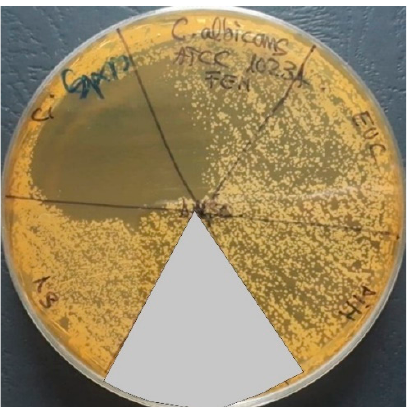
Figure 6. The aspect of the inhibition zones expressed by the yeast strain Candida albicans ATCC 10231 in the presence of tested EO at 1/10 dilution in DMSO; FEN (fennel EO); SV (sage EO); EUC (eucalyptus EO); CI (thyme EO); PIN (pine EO).